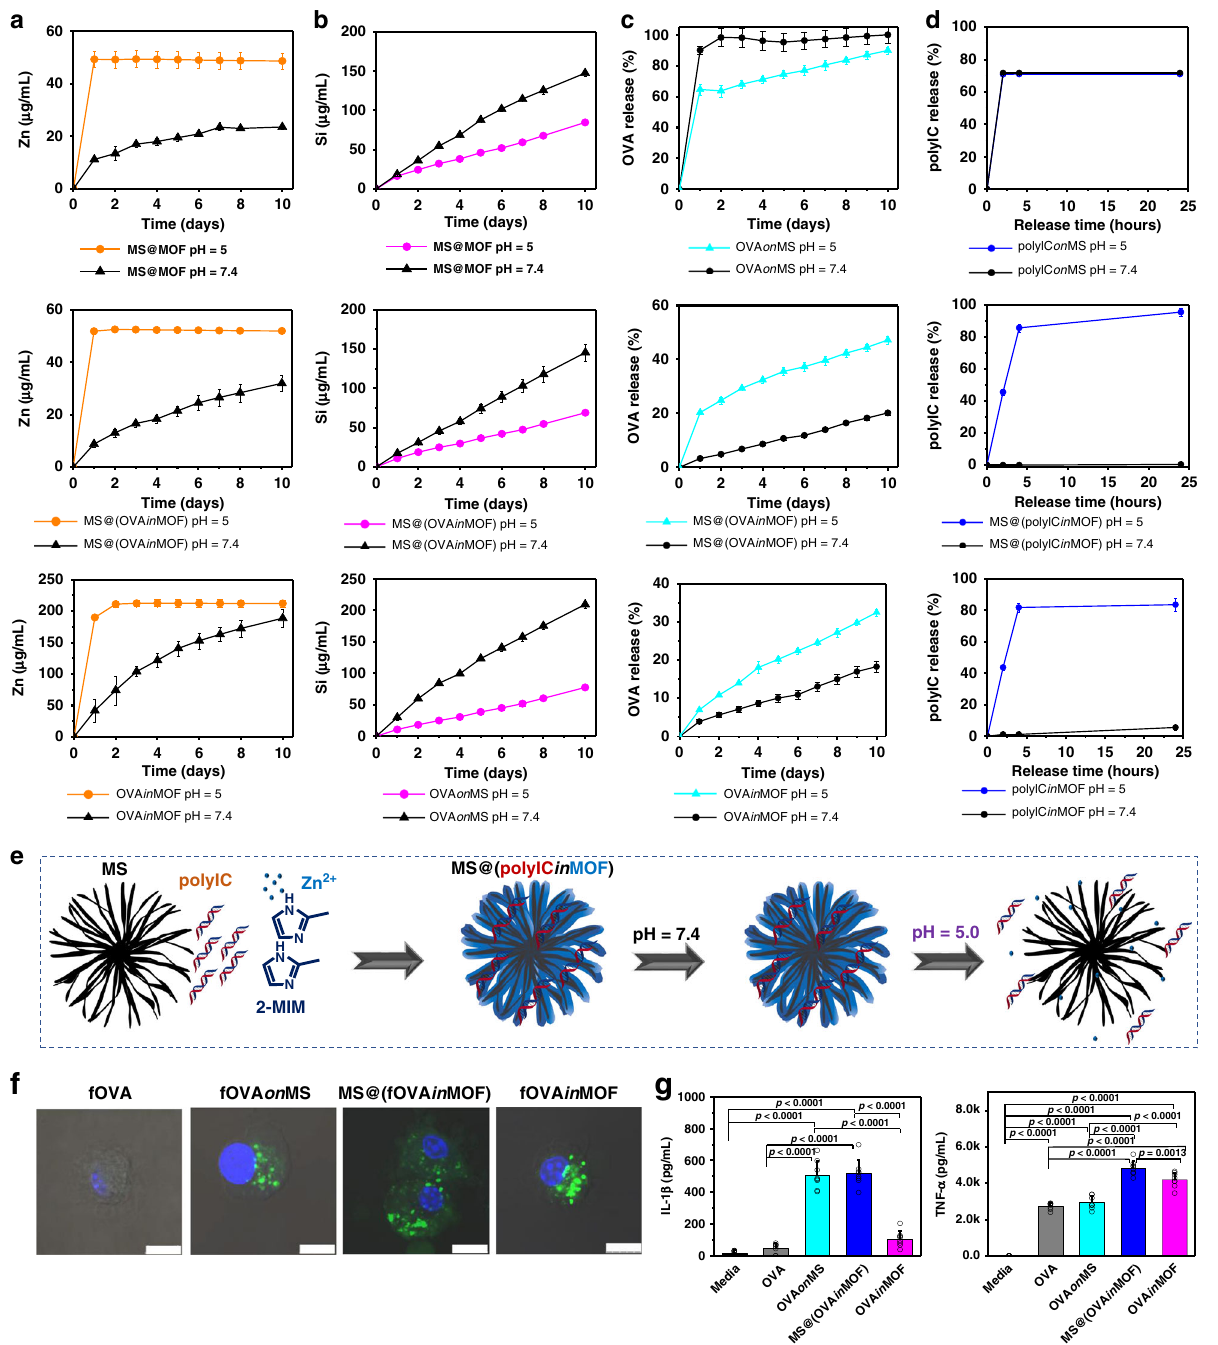
Fig. 2 Degradation and biomolecule release of nanoadjuvants, and BMDCs activation in vitro. a , b pH-responsive degradation of MS, MOF-gated MS and MOF ( n = 3 independent samples); c OVA release from OVA on MS, MS@(OVA in MOF) and OVA in MOF at different pH values ( n = 4 independent samples); d polyIC release from polyIC on MS, MS@(polyIC in MOF) and polyIC in MOF at different pH values ( n = 3 independent samples). e Scheme